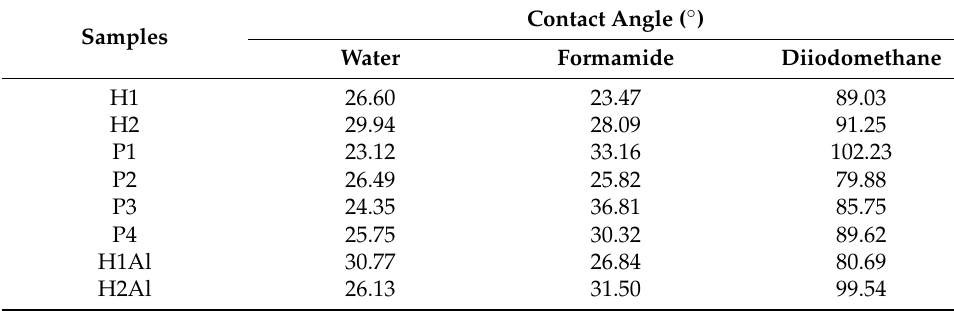
Table 2. Mean static contact angles determined by the sessile drop